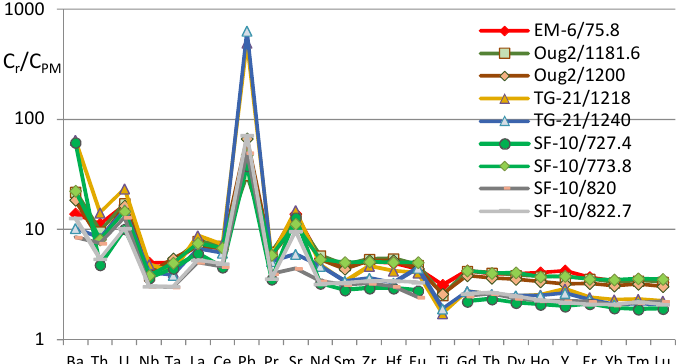
Figure 6. Spider-diagrams for rocks of the Talnakh intrusion Normalized to Primitive Mantle (PM). Data in Table 2. Branches: boreholes OUG-2, SF-10—North-Eastern, EM-6—South-Western, TG-21— South-Western.